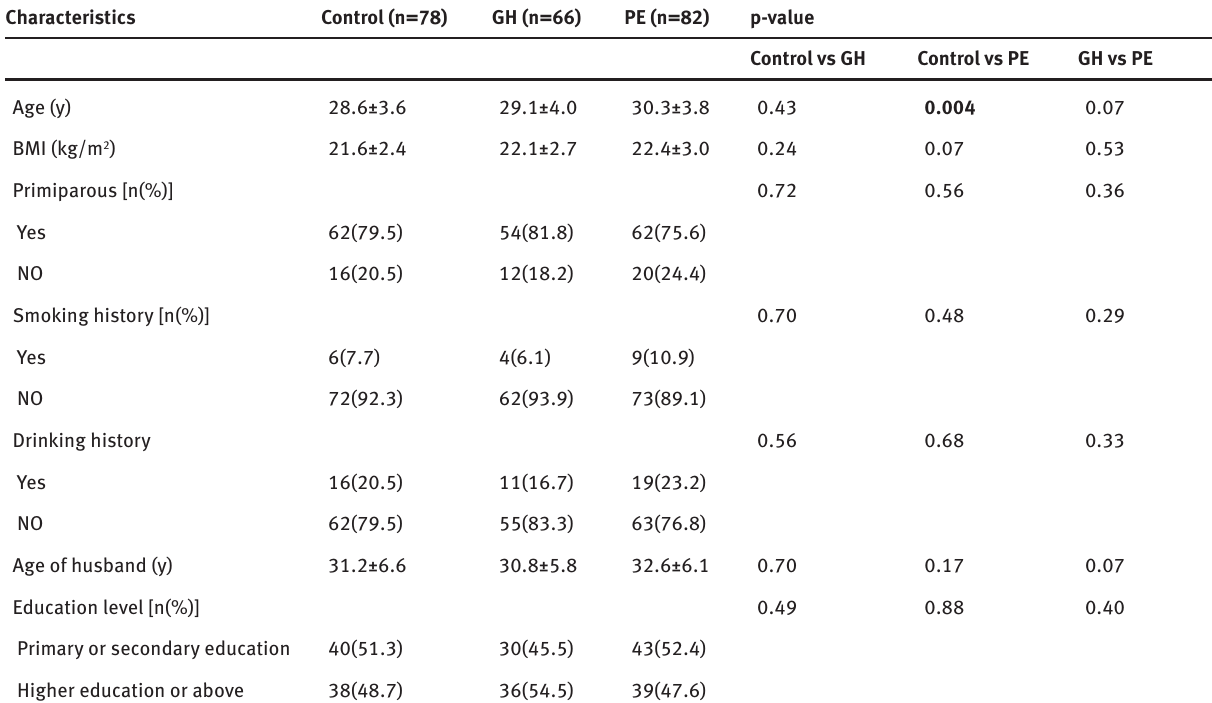
Table 1: Baseline demographic characteristics of the included cases. Characteristics